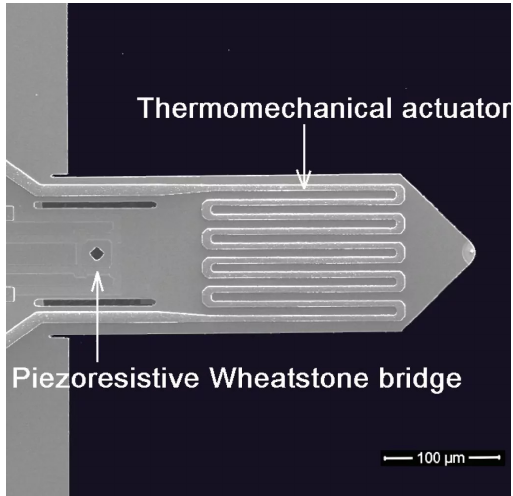
Figure 3. Active piezoresistive cantilever used in the conducted experiments. Cantilevers purchased from NanoAnalytic GmbH. Picture taken from the product website.